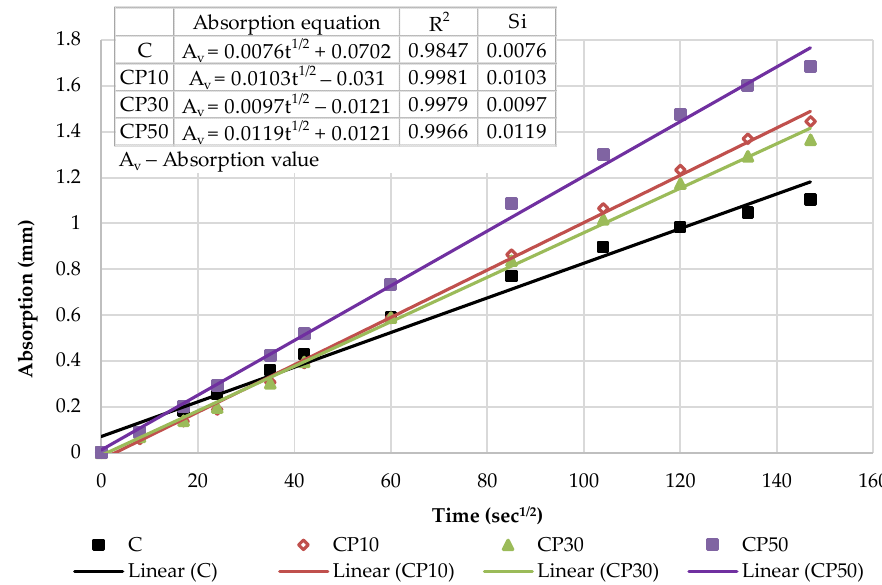
Figure 9. The initial capillary absorptivity of CP–based mortars.